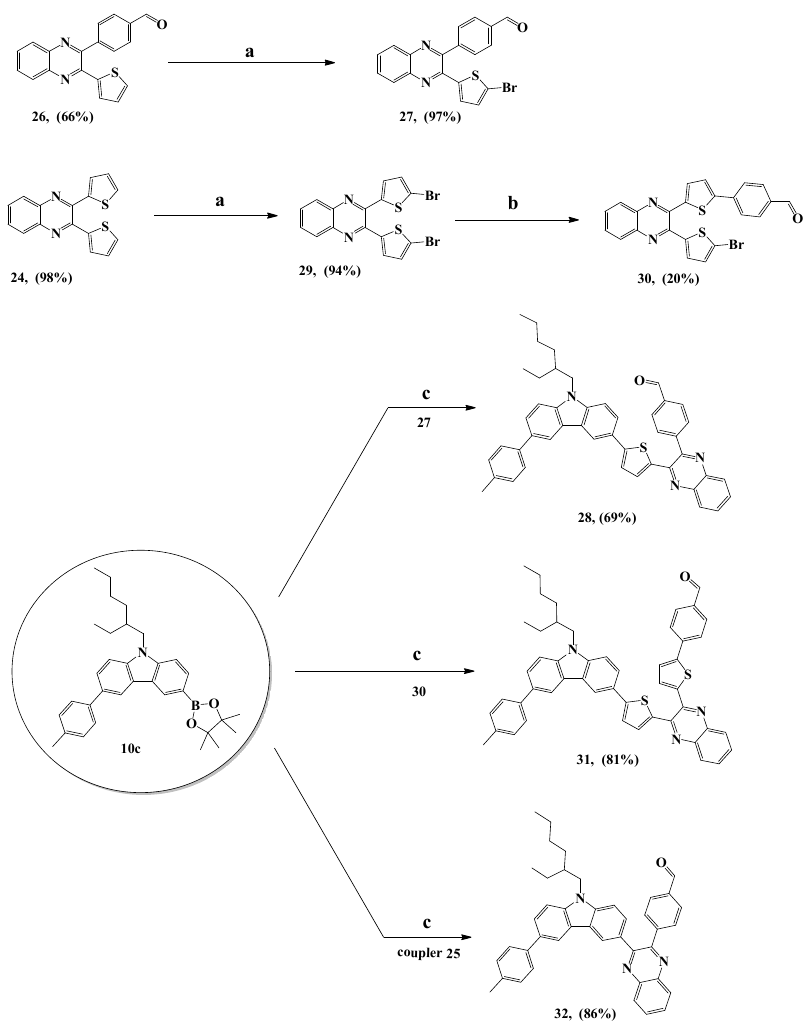
Scheme 4. C-C coupling reactions of N -alkyl carbazole boronic acid pinacol ester derivative with